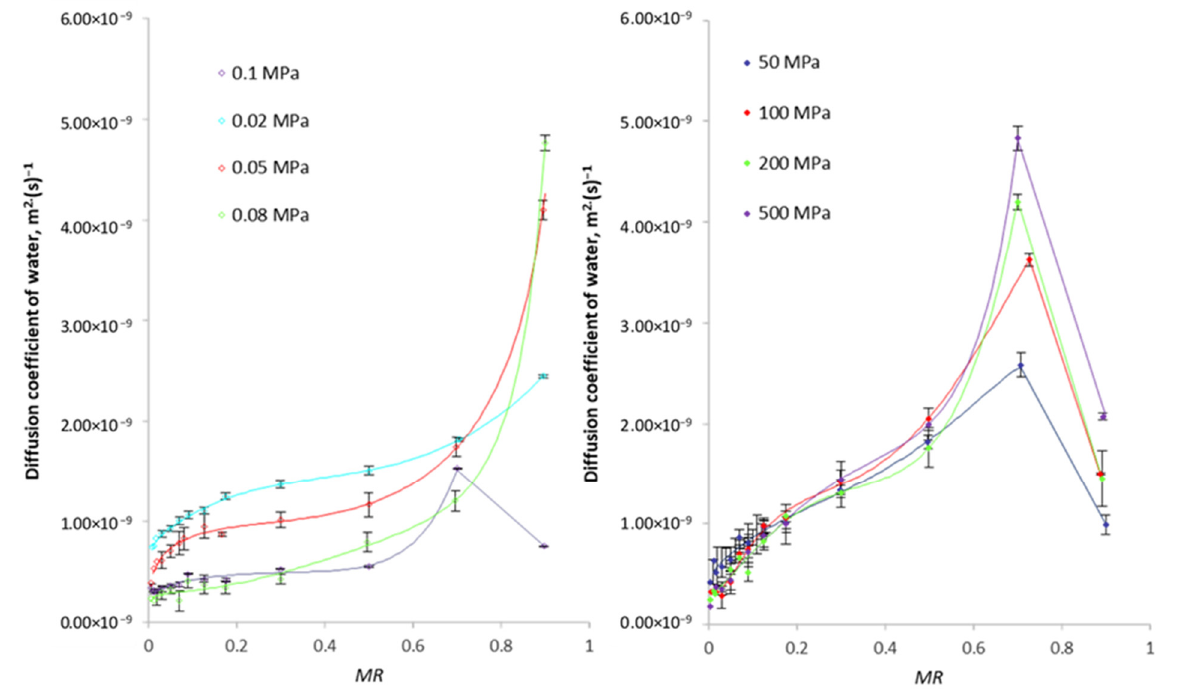
Figure 5. Change in the water diffusion coefficient during drying of apples pre-osmotically dehydrated under varied pressure.